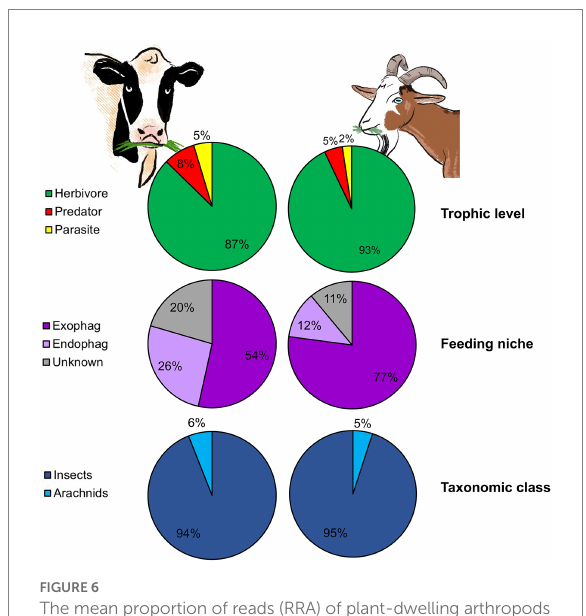
FIGURE 6 The mean proportion of reads (RRA) of plant-dwelling arthropods (PDA) detected in the feces of two different LMH species according to trophic level, feeding niche, and taxonomic class. The left pie charts show the RRA of PDA detected in cattle feces (reconstructed from Berman and Inbar, 2022). The right pie charts show the RRA of PDA detected in goat